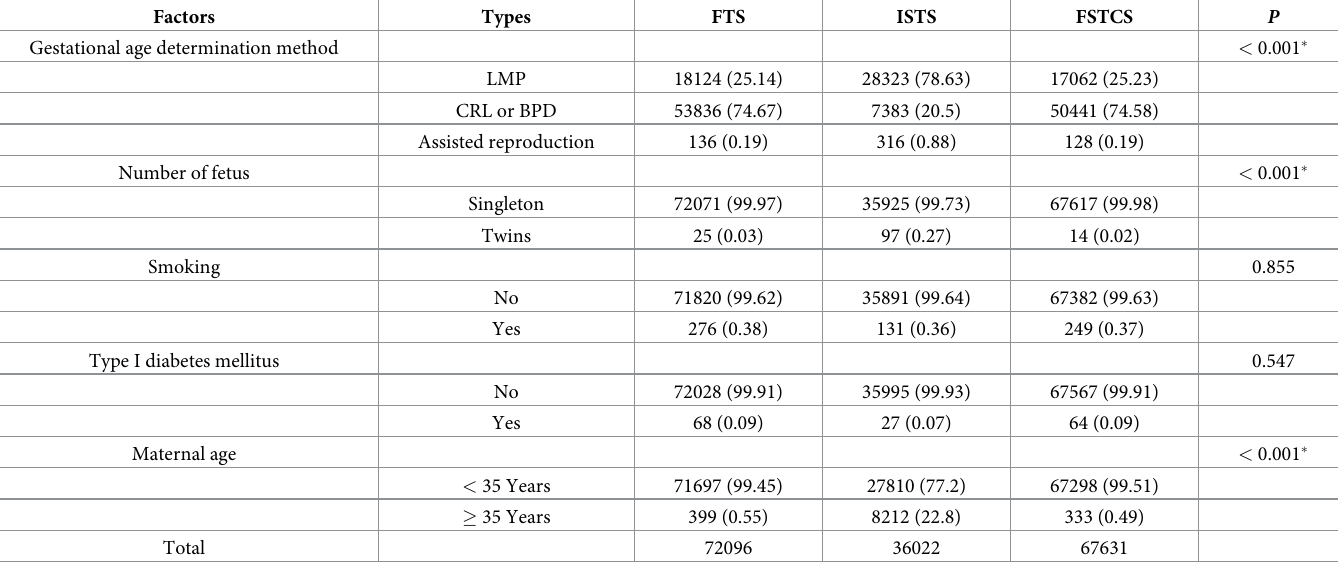
Table 1. Basic demographic data of pregnant women in three different screening programs n